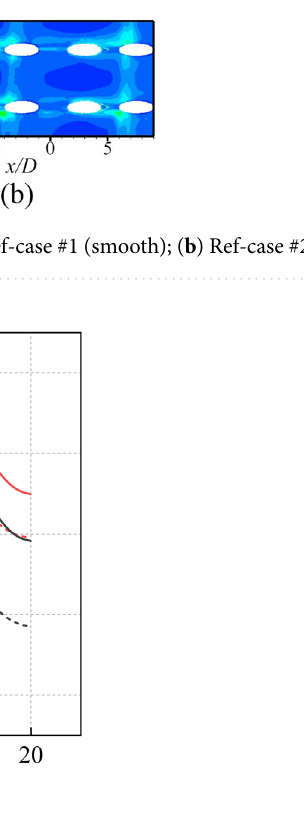
Figure 29. Laterally-averaged ϕ for different